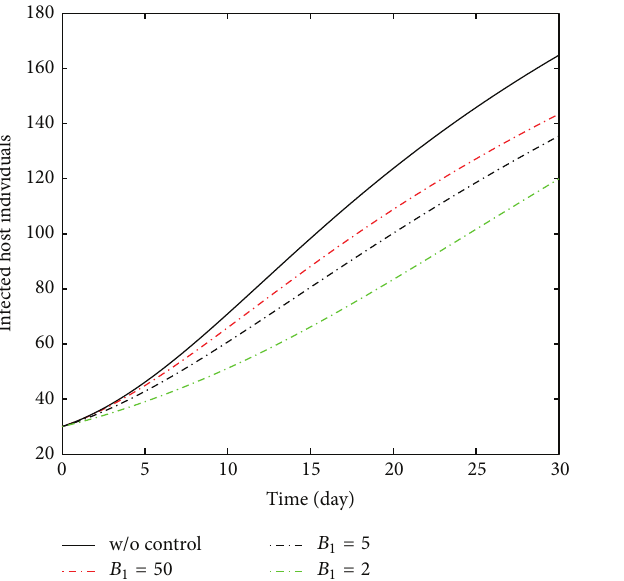
Figure 16: Plot of different weight constants on the control (without control, 𝐵 1 = 50 , 𝐵 1 = 5 , and 𝐵 1 = 2 ).